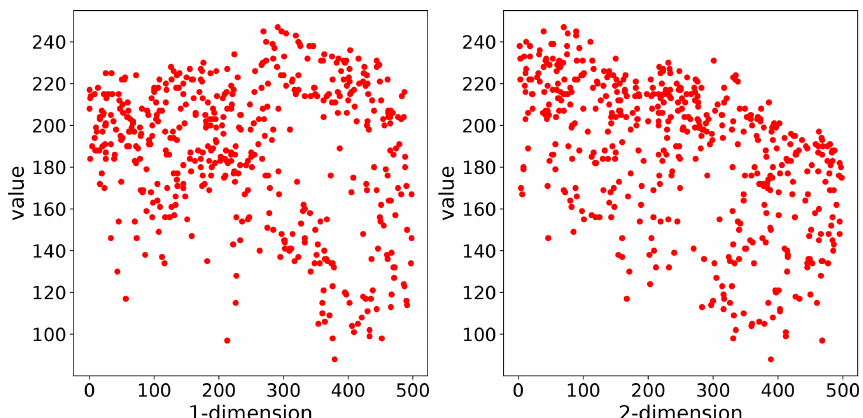
Figure 3. Scatterplot of the observation values in the pancake dataset related to only one coordinate dimension. As the pancake dataset was 2D, 1-dimension corresponds to the x coordinate and 2-dimension to the y coordinate of the pancake sample. This plotting procedure can help the user to identify a dependence on the location for the data sample, which can violate the second-order